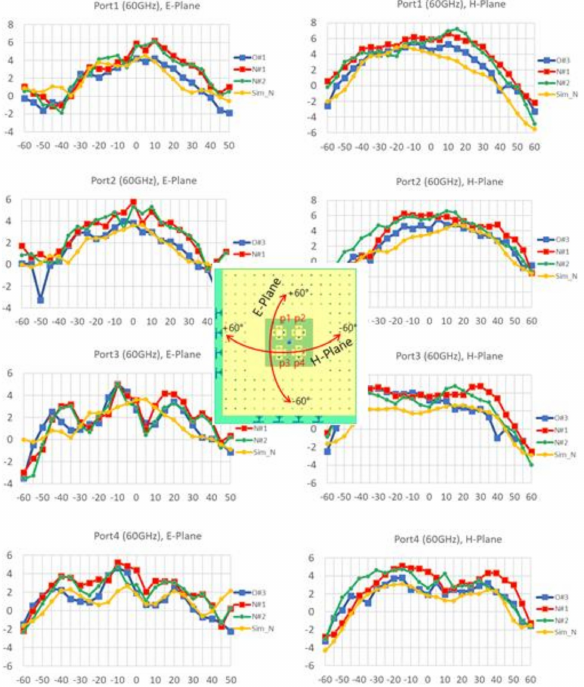
Figure 15. Results of the E/H-plane beam patterns for each single